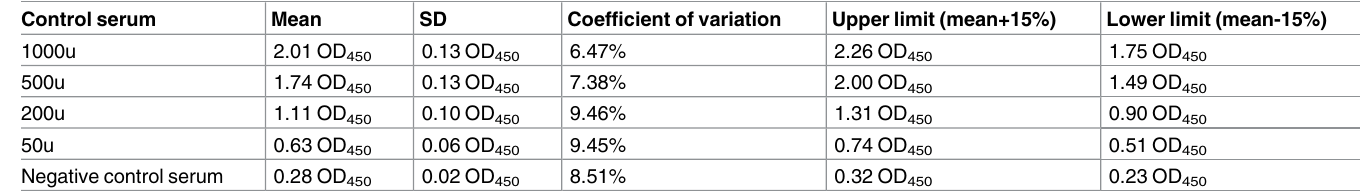
Table 2. The mean OD 450 value for the five controls sera used on the ELISA plates. Mean, SD and coefficient of variationfor the five serum standards run alongsidethe Ugandansamplesacross 24 plates. Data were similar for the standards run alongsidethe Laotianand Gambian samples.